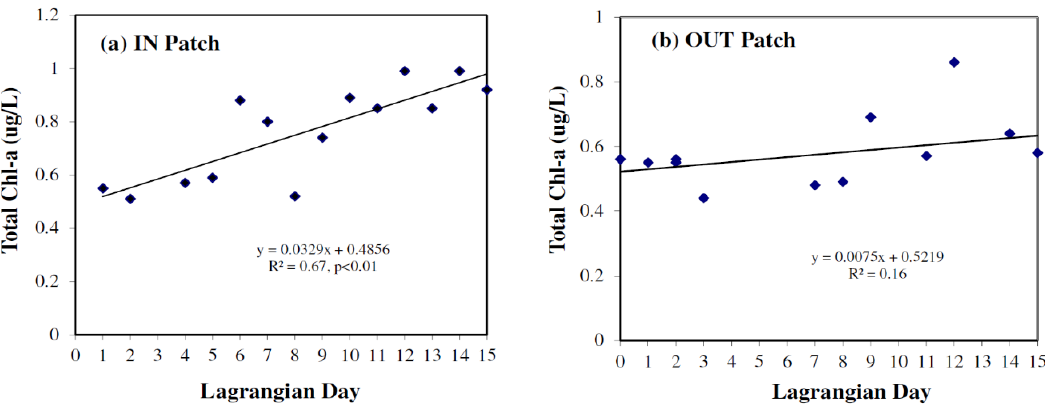
Figure 3. Total chlorophyll a (µg/L) in underway surface seawater samples versus Lagrangian day for the ( a ) IN and ( b ) OUT patch.